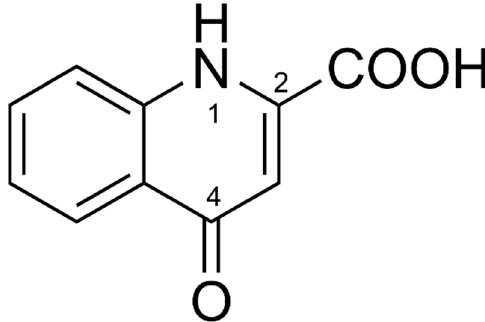
Figure 6. Chemical structure of KYNA keto tautomer.